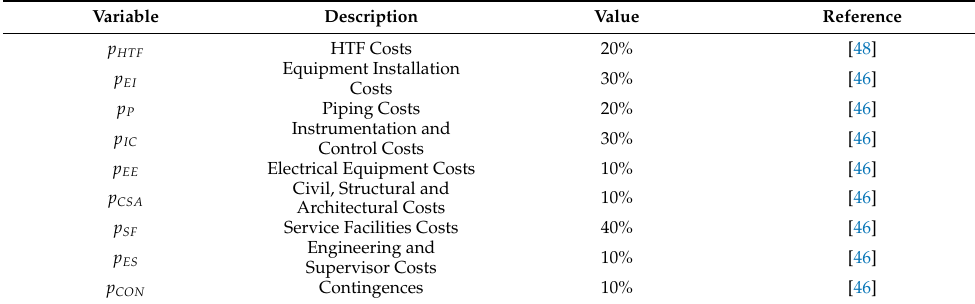
Table 3. Cost multipliers that were used in the CAPEX